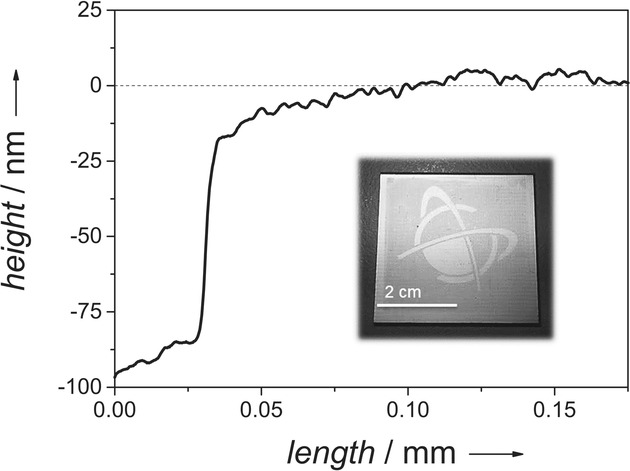
Height profile of a film of pNonOx80-stat-pDc=Ox20 after illumination and development. The copoly(2-oxazoline) had been spincast on a gold-coated FR4 substrate and been illuminated through a mask.